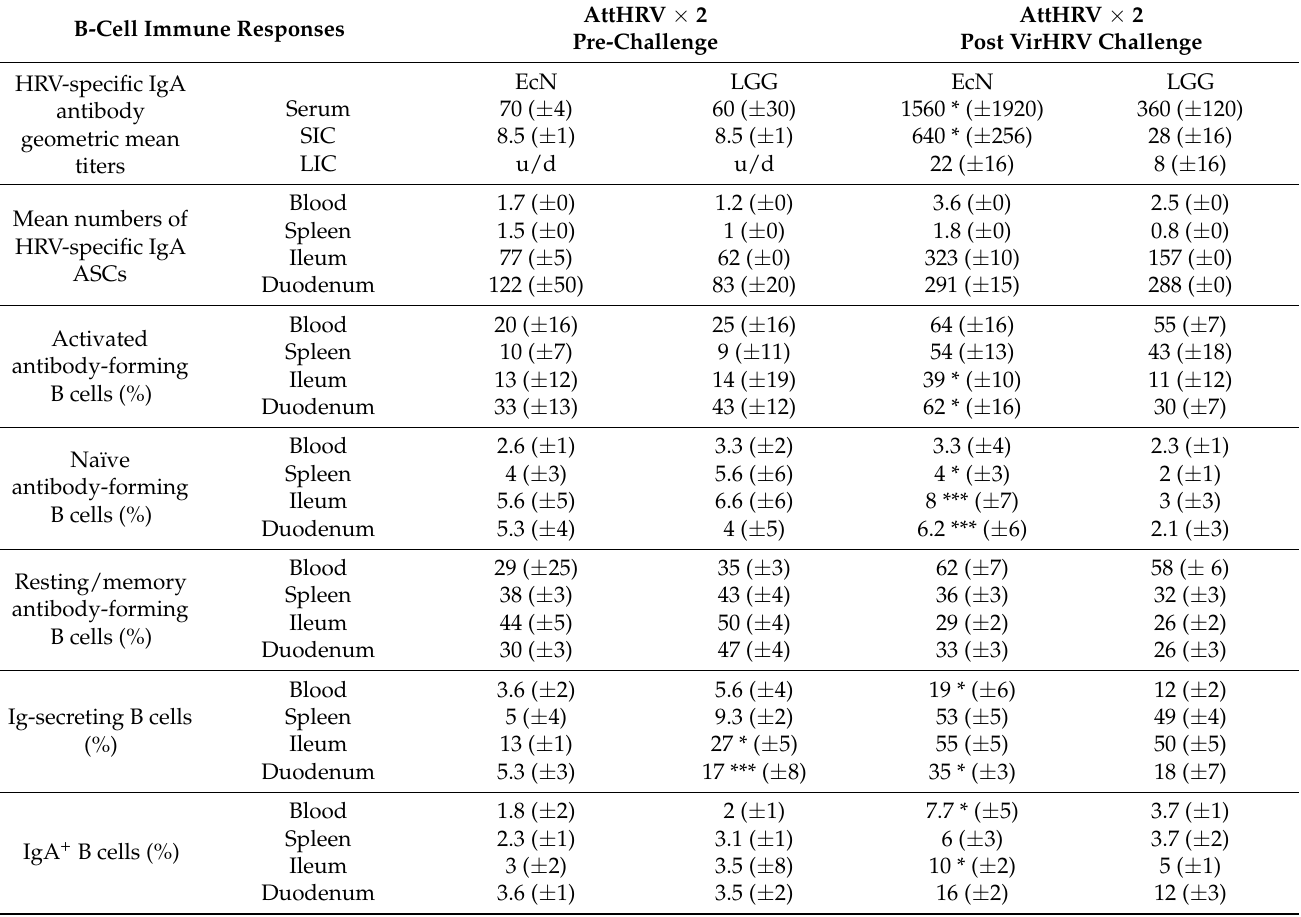
Table 2. EcN colonization affected the HRV-specific antibody titers, antibody-secreting cells, and B-cell subpopulations in